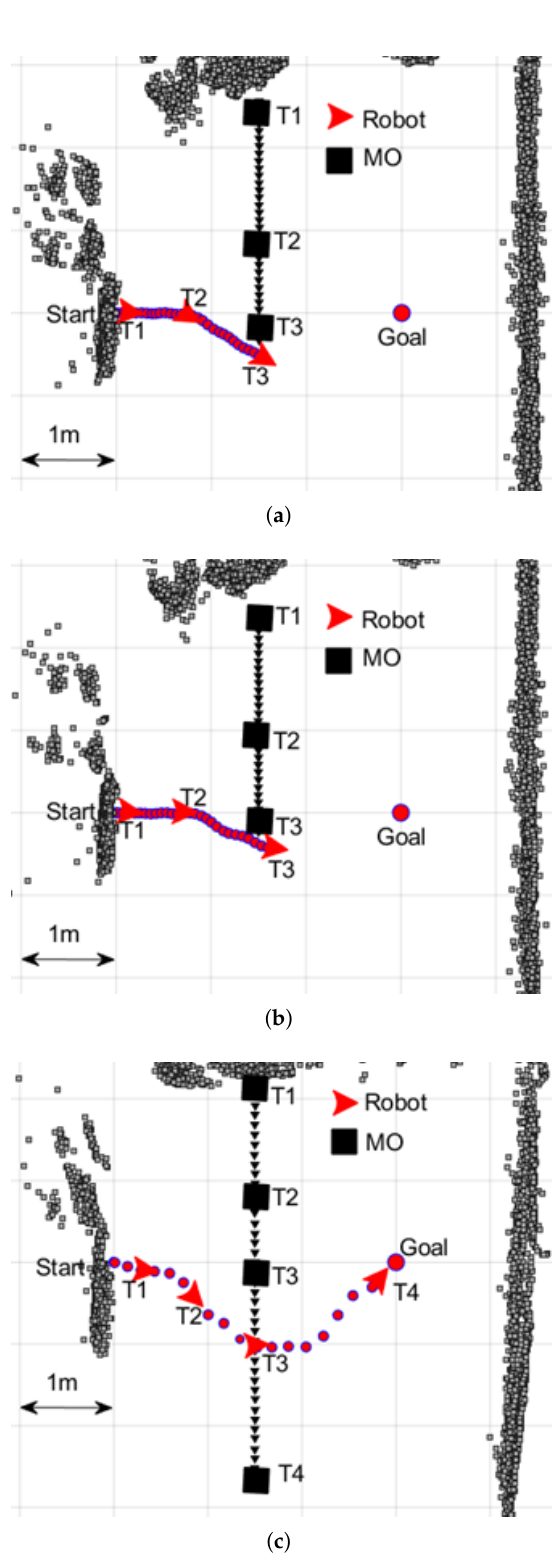
Figure 9. The robot’s paths observed in Experiment 3 with different configurations. The robot’s and obstacle’s locations at four different time instants are shown as T1–T4. ( a ) Robot without the new FCL and the DOPP module, ( b ) robot with the new FCL and without the DOPP module, and ( c ) robot with the new FCL and the DOPP